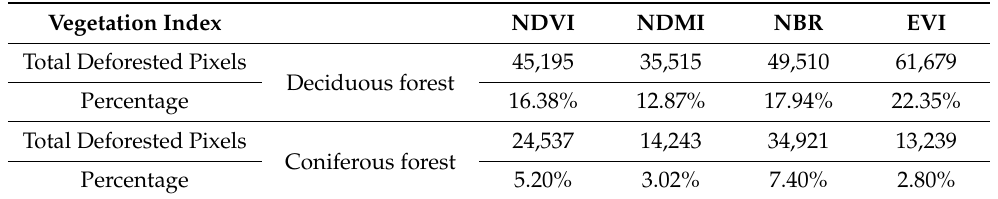
Table 3. Percentage of the deforested area detected by each VI with respect to deciduous and coniferous forests.